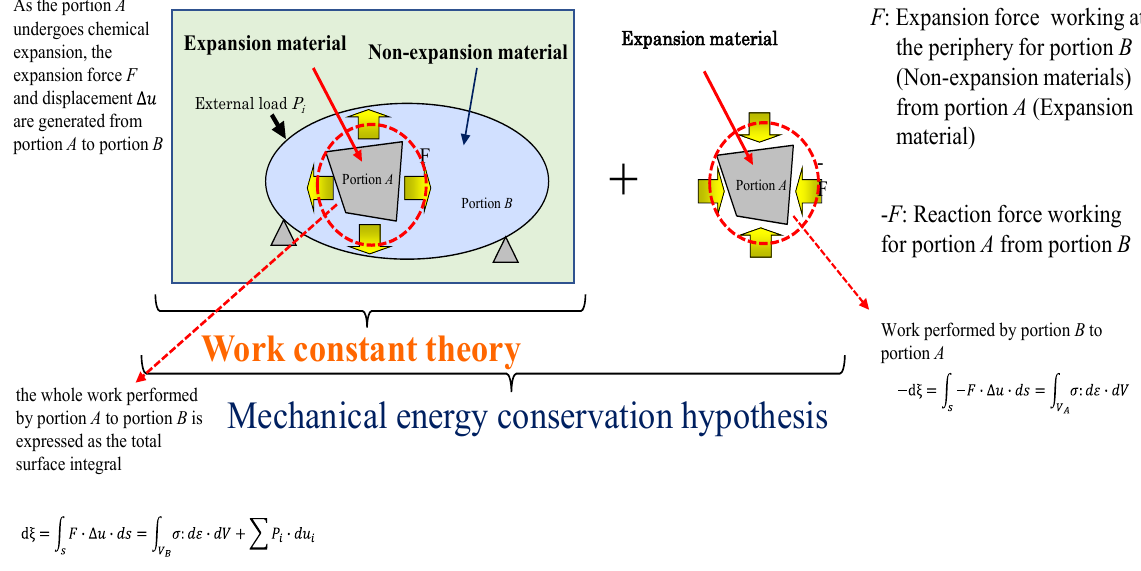
Figure 10. Concept of the mechanical energy conservation hypothesis. As portion A undergoes chemical expansion, the expansion force F and displacement are generated from portion A to portion B. Therefore, the entire work performed by ∆𝑢𝑢 portions A to B is obtained as the total surface integral. F working at the periphery of portion B from portion A leads to the reaction force (- F ), which works for A from B portion. Therefore, the work carried out by B to A portion is dξ , which is equal to the strain energy increment within portion A, which is the expanding